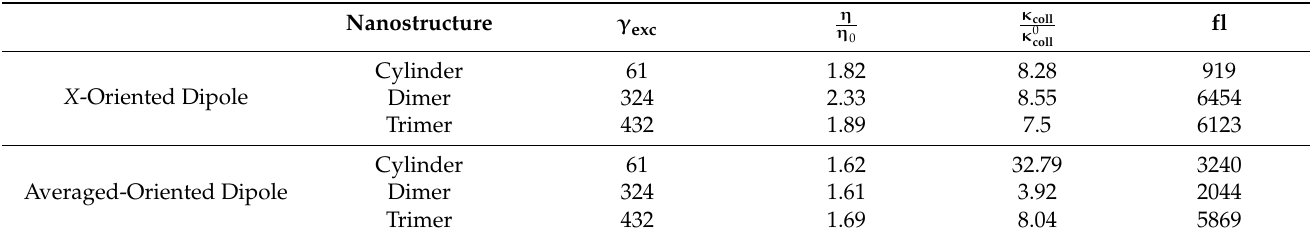
Table 3. Comparison of the fluorescence enhancements of an emitter coupled with arrays of different geometries at λ = 650 nm. The dipole is in the gap of the dimer and trimer and on the side of the cylinder.